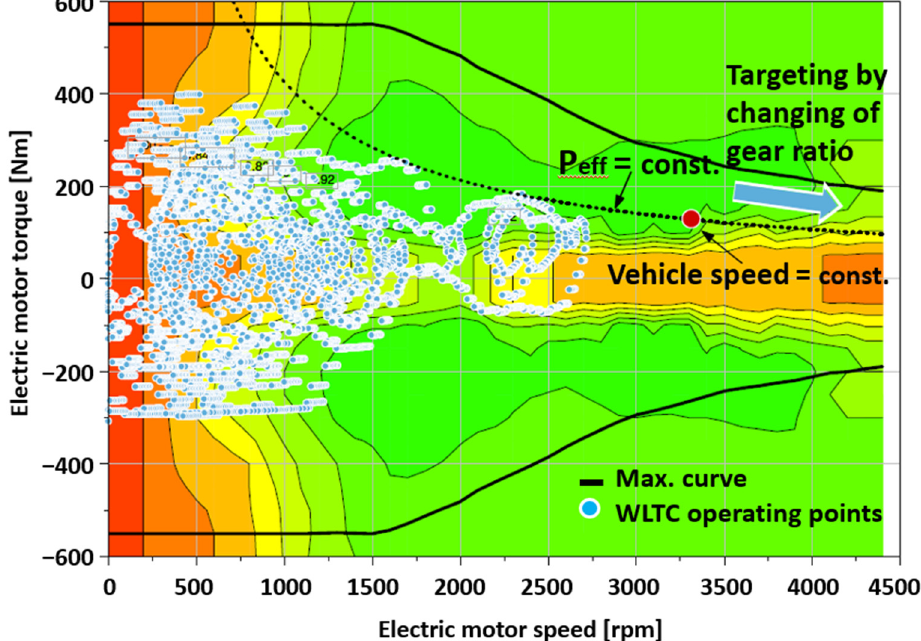
Figure 9. Energy-weighted operating points of the EM (max. 80 kW) for a serial hybrid on